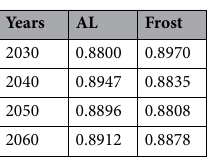
Table 5. Accuracy of the CA–Markov method for predicting the AL pattern and frost-affected areas in the LUB.